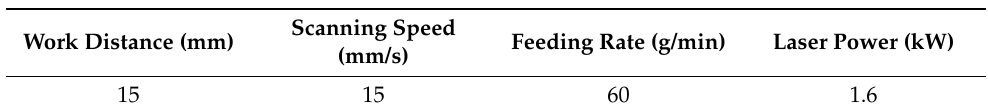
Table 6. Process parameters of HF.